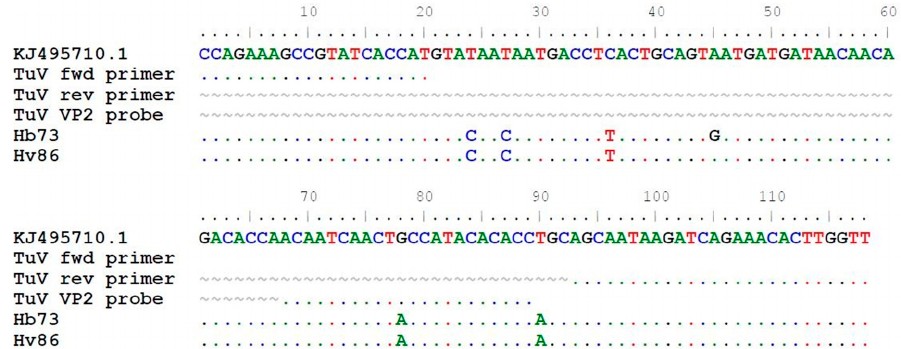
Figure 2. Alignment of the 118 nt sequenced qPCR amplicons from TuV DNA-positive stool samples in the current study to the only published TuV reference sequence KJ495710.1 (3085–3202 bp). Dot (.) indicates identical nucleotides and tilde (~) lacking nucleotides.